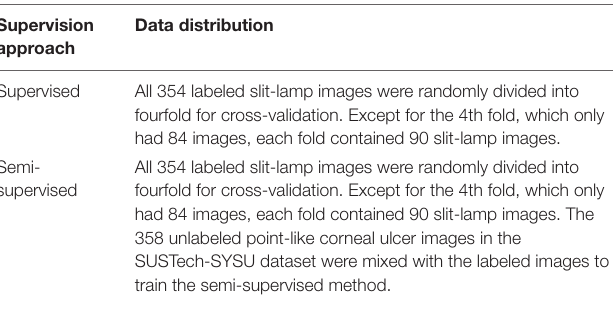
TABLE 1 | Experimental data